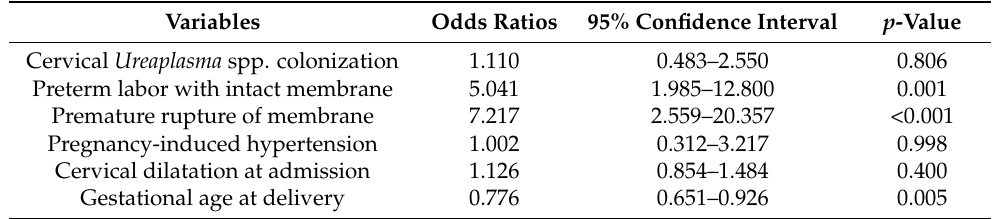
Table 3. Multivariate logistic regression analysis of the clinical factors in patients with histological chorioamnionitis.